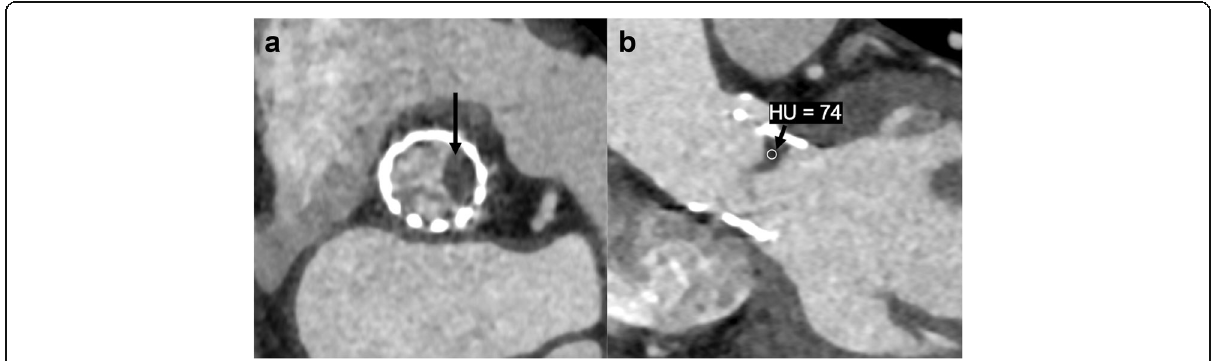
Fig. 14 A 67-year-old female status transcatheter aortic valve replacement (TAVR) using Sapiens valve (Edwards Lifesciences) with suspected aortic valve lesion on echocardiogram. Axial ( a ) and coronal oblique ( b ) reconstructed CTA images reveal biconvex hypoattenuating (Hounsfield unit, 74) leaflet and left cusp thickening causing restricted motion (seen on cine), consistent with